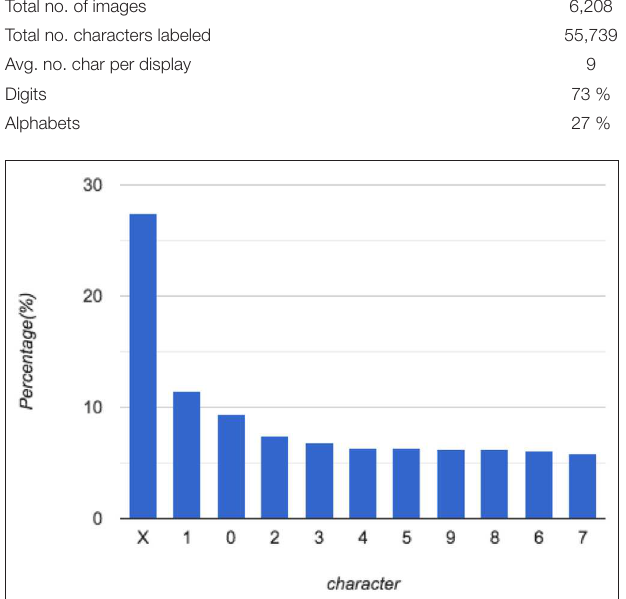
FIGURE 5 | Distribution of characters; X represents non-digit characters. TABLE 2 | Image quality